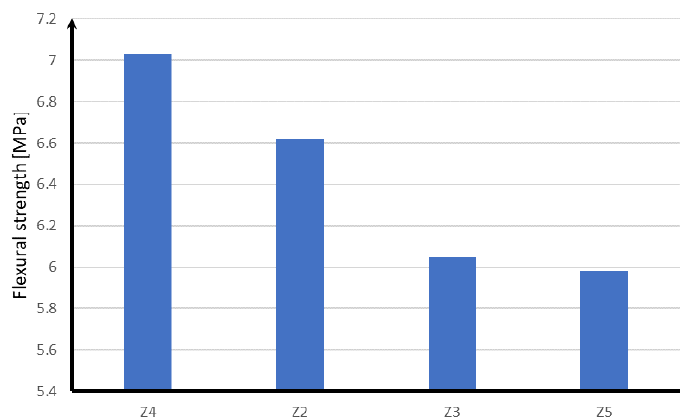
Figure 19 . Stresses in the track plate depending on the fibers used in the block supports.